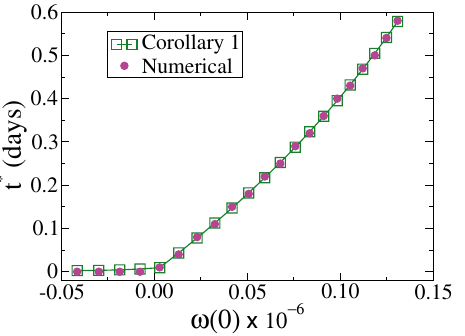
Figure 2. Optimal initial time of the strict quarantine t ∗ vs w (0) for τ = 10 and κ = 0 . The other parameters are γ = 0.1, σ m = σ f = 1.5, σ s = 0 and T = 260